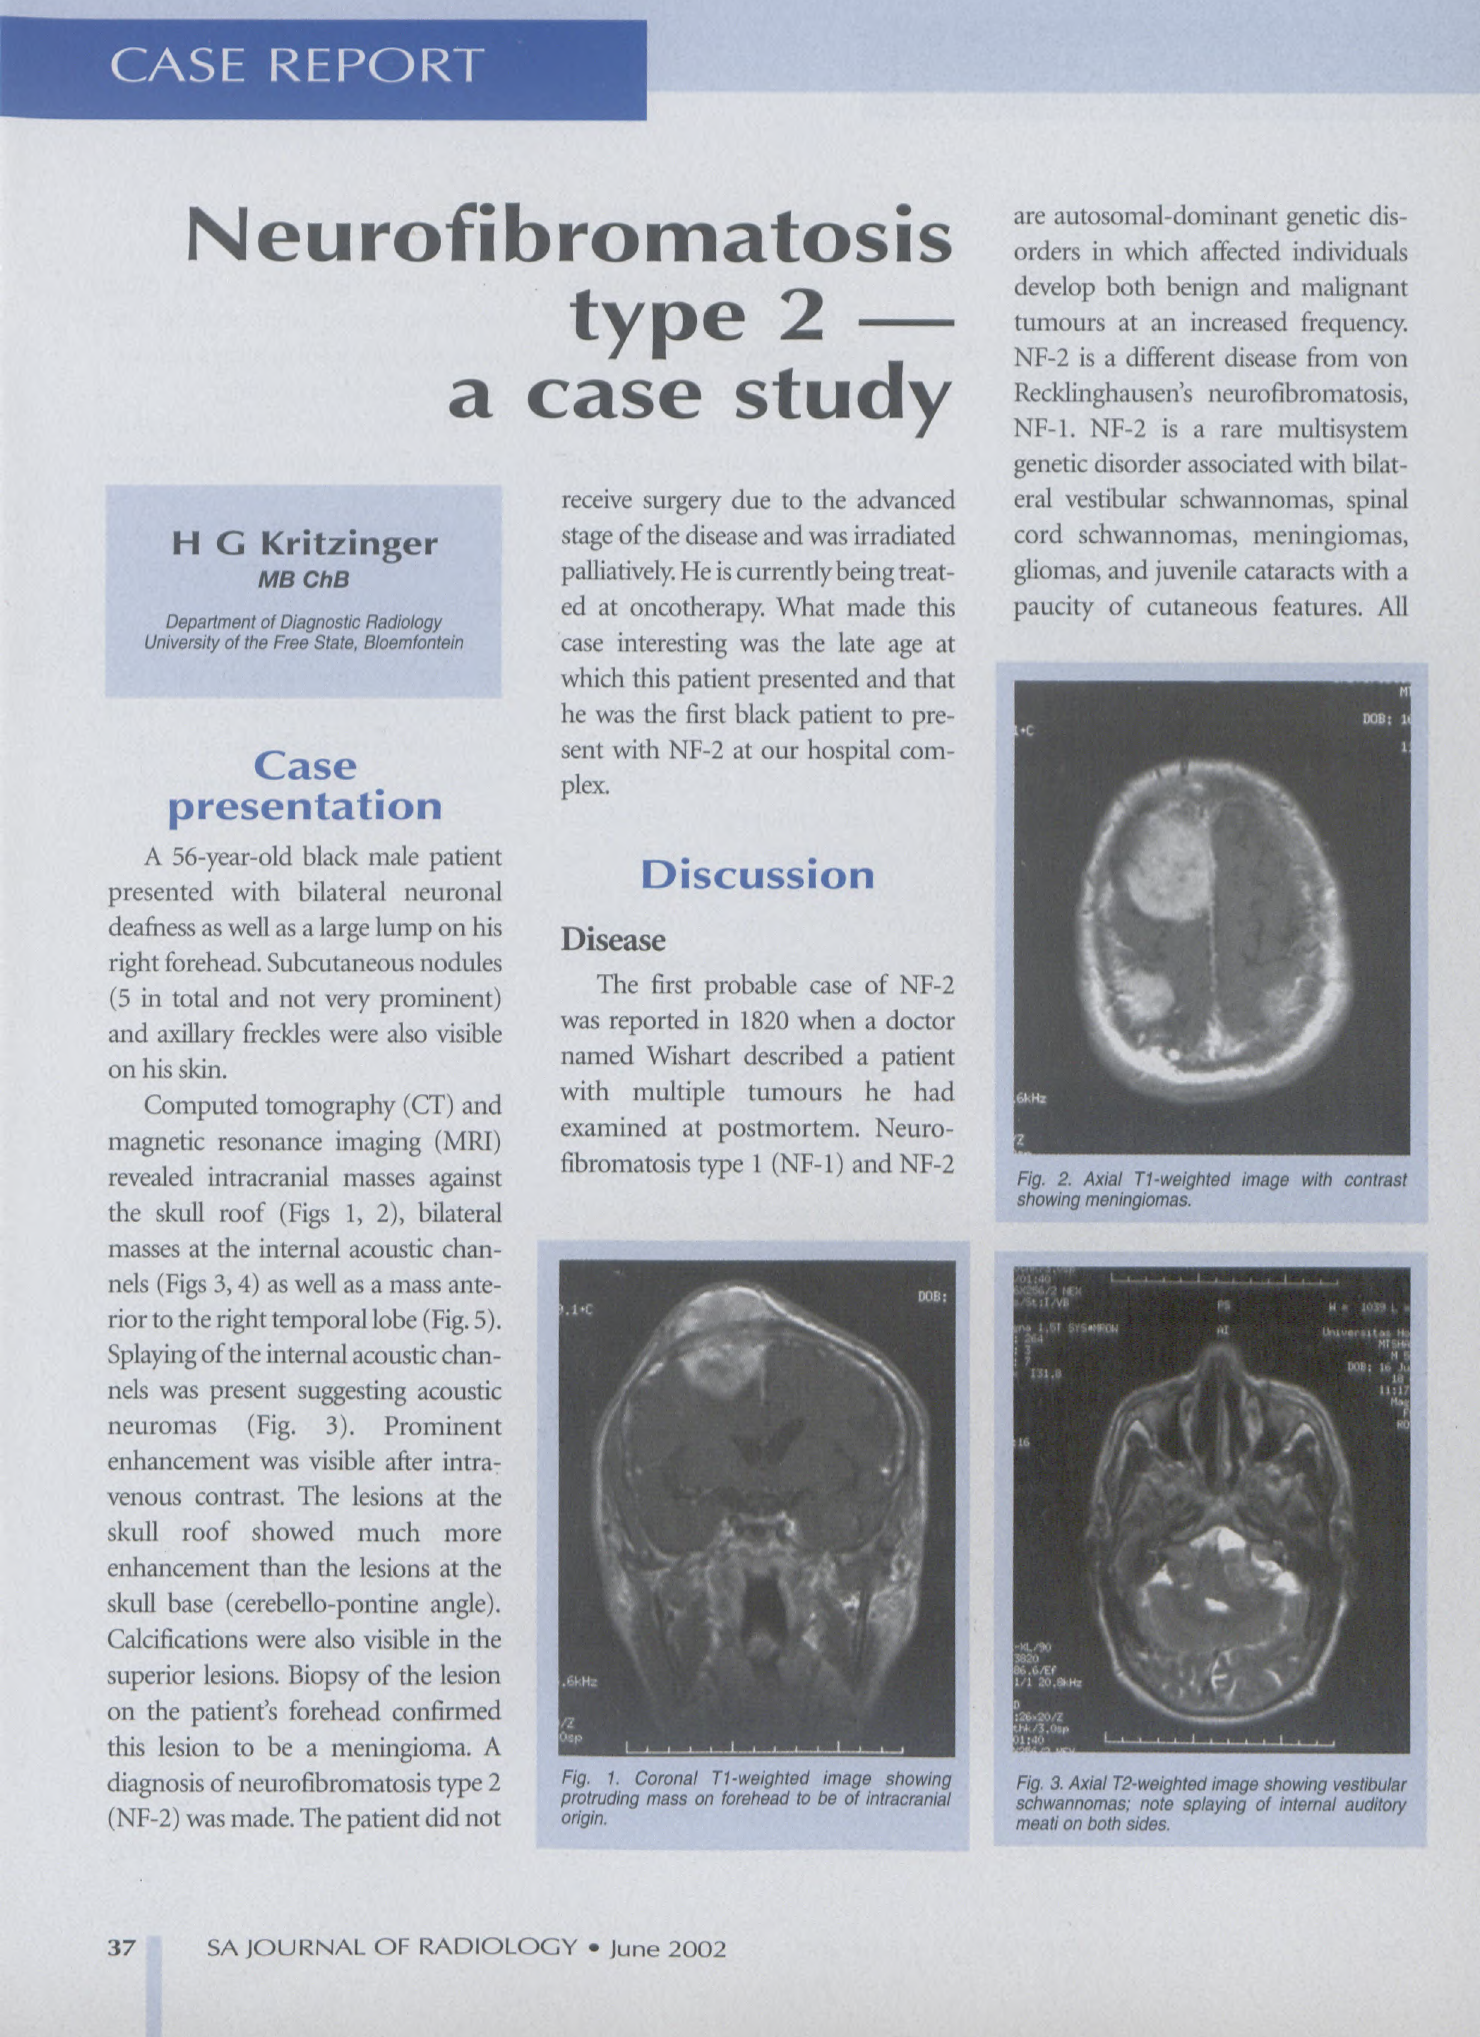
Fig. 3. Axial T2·weighted image showing vestibular schwannomas; note splaying of internal auditory meati on both